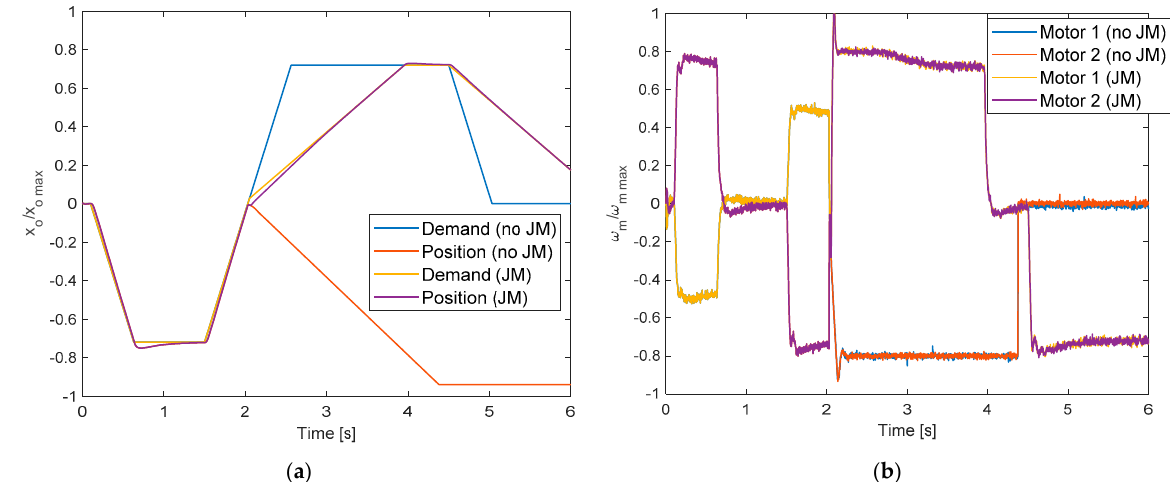
Figure 13. Jamming Monitor (JM) effect with block of screwshaft translation (jamming of the external screw-nut coupling) at 2.03 s (FDI latency = 15 ms): ( a ) output position; ( b ) motors speeds.